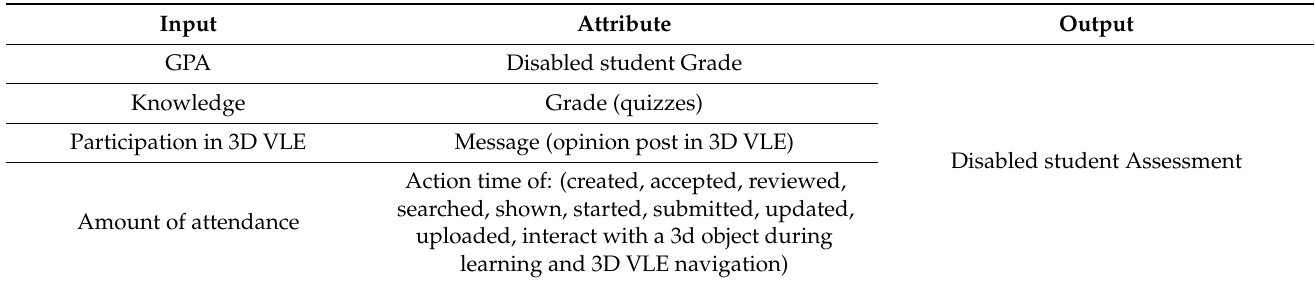
Table 1. 3D VLE FIS input and Output